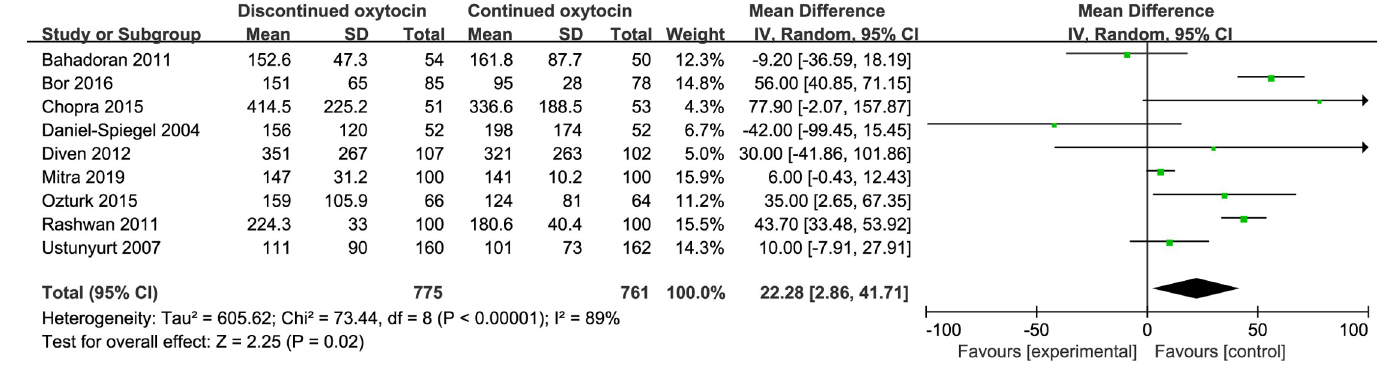
Fig 11. Pooled results for each outcome.